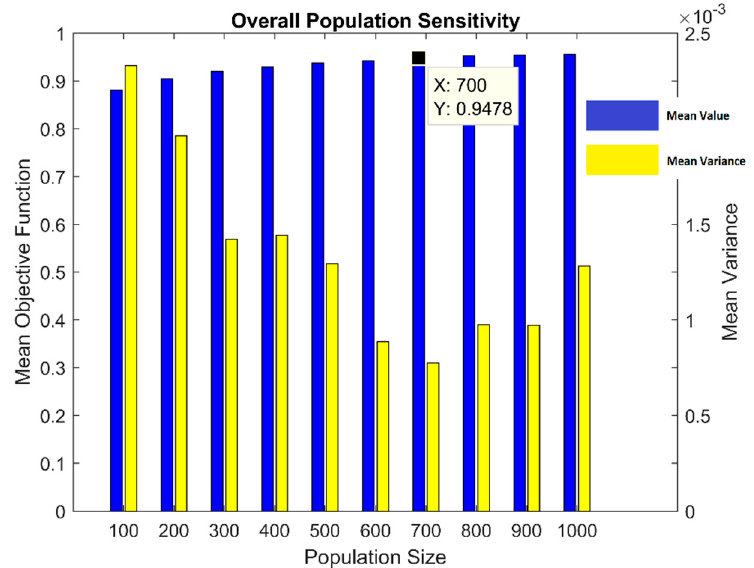
Figure 7. Sensitivity analysis of genetic algorithm (GA) evaluating the population size.